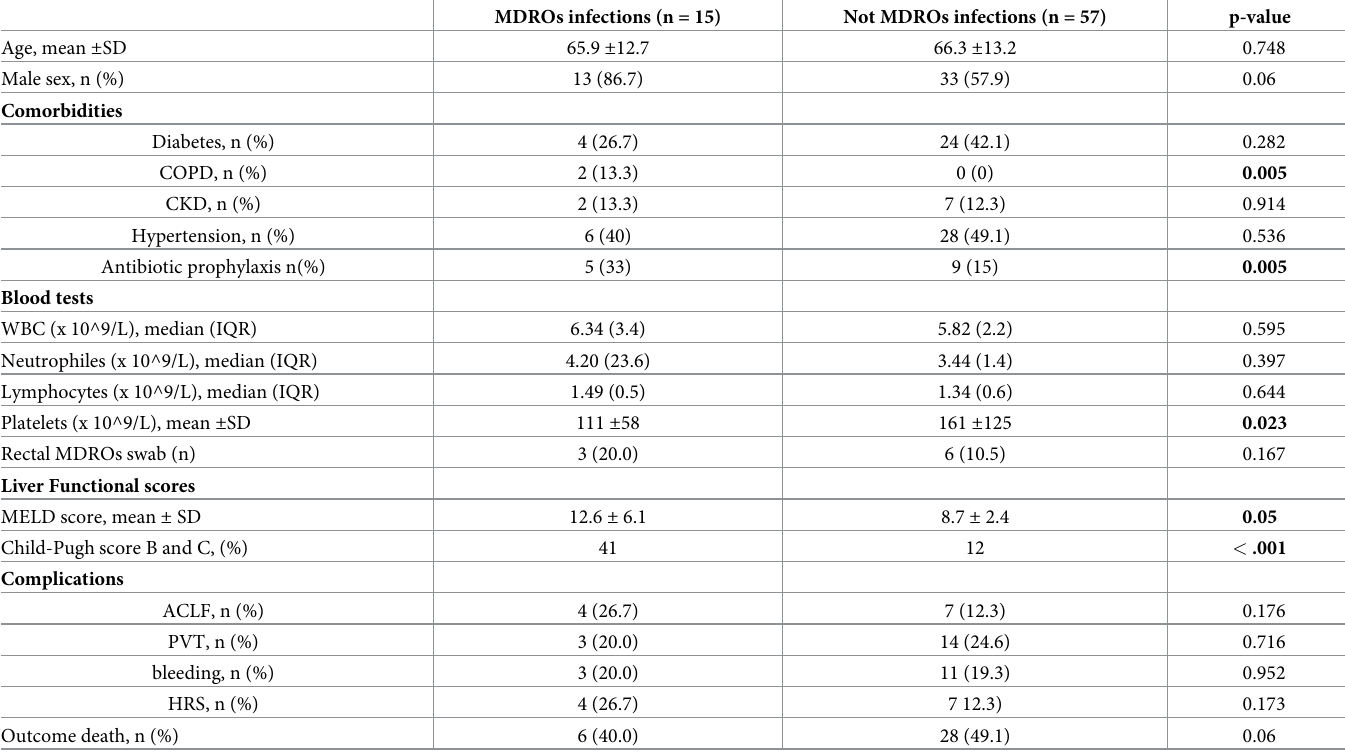
Table 3. Comparison of baseline characteristics of infected patients with MDROs and infected patients without